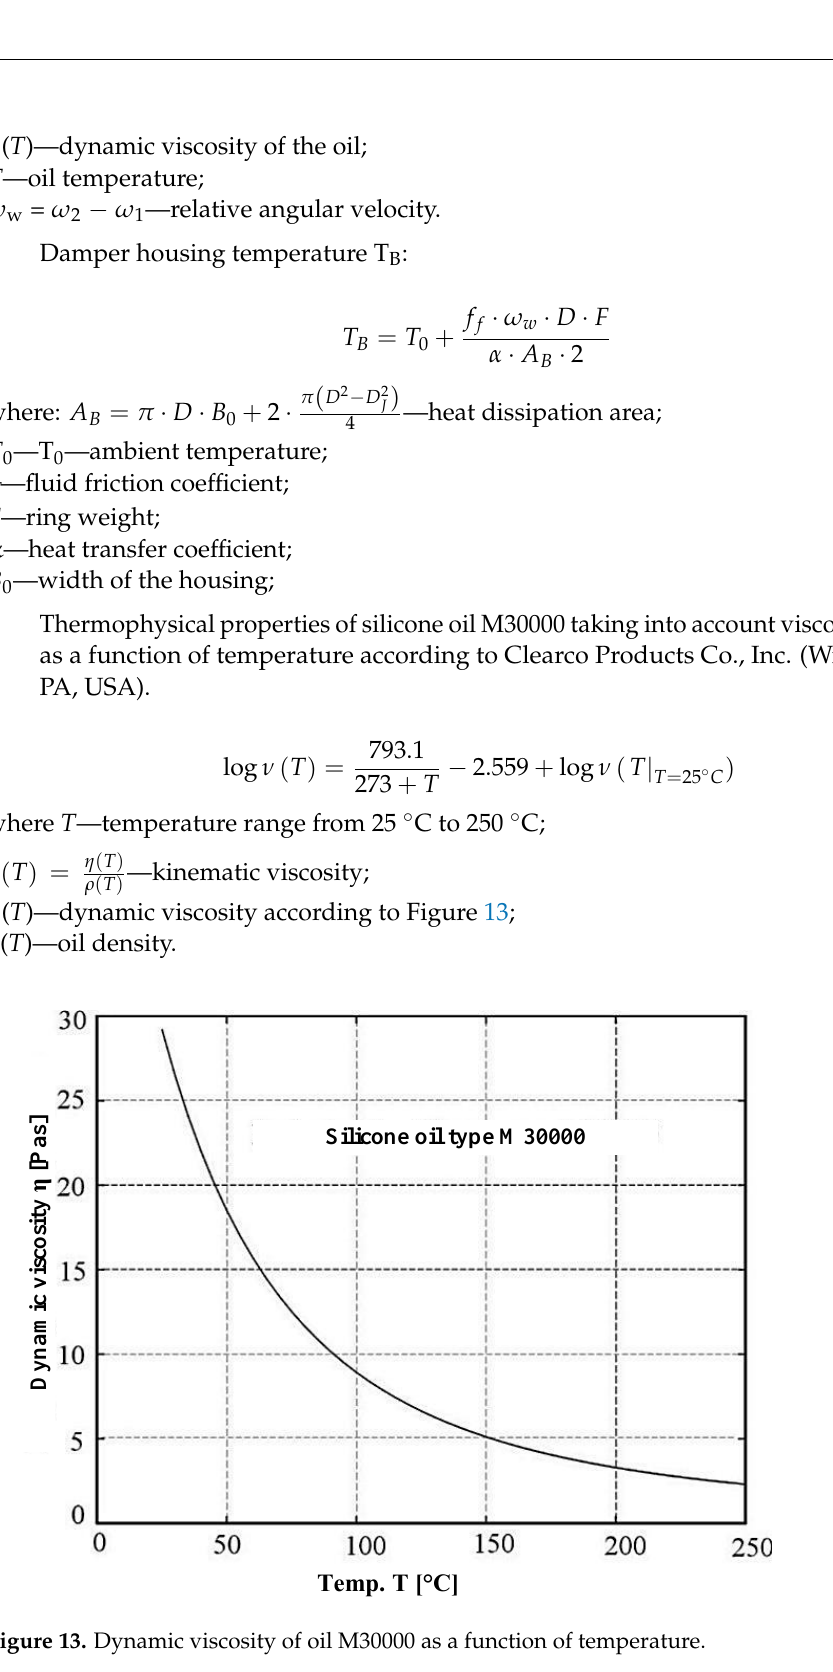
Table 1. Main damper parameters taken for calculations.